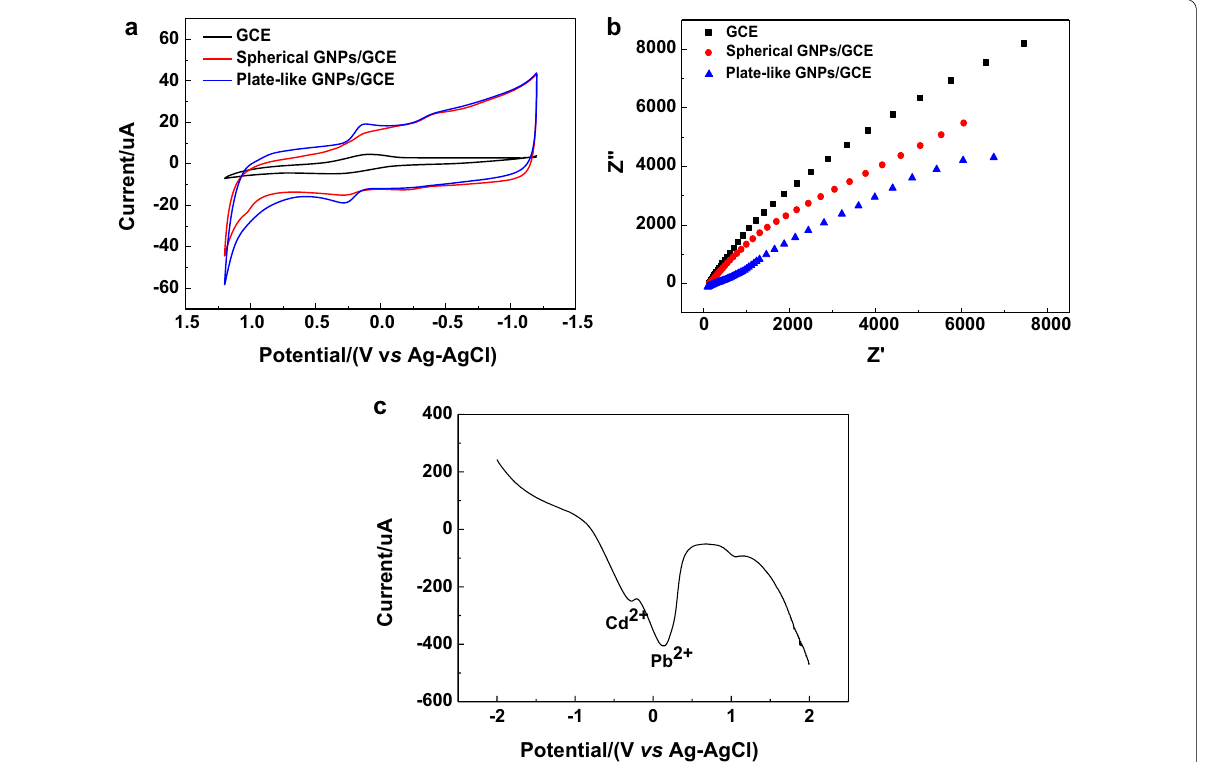
Fig. 10 CV ( a ) and EIS ( b ) characterization of the prepared electrodes. c Anti-interference performance of the plate-like GNPs/GCE